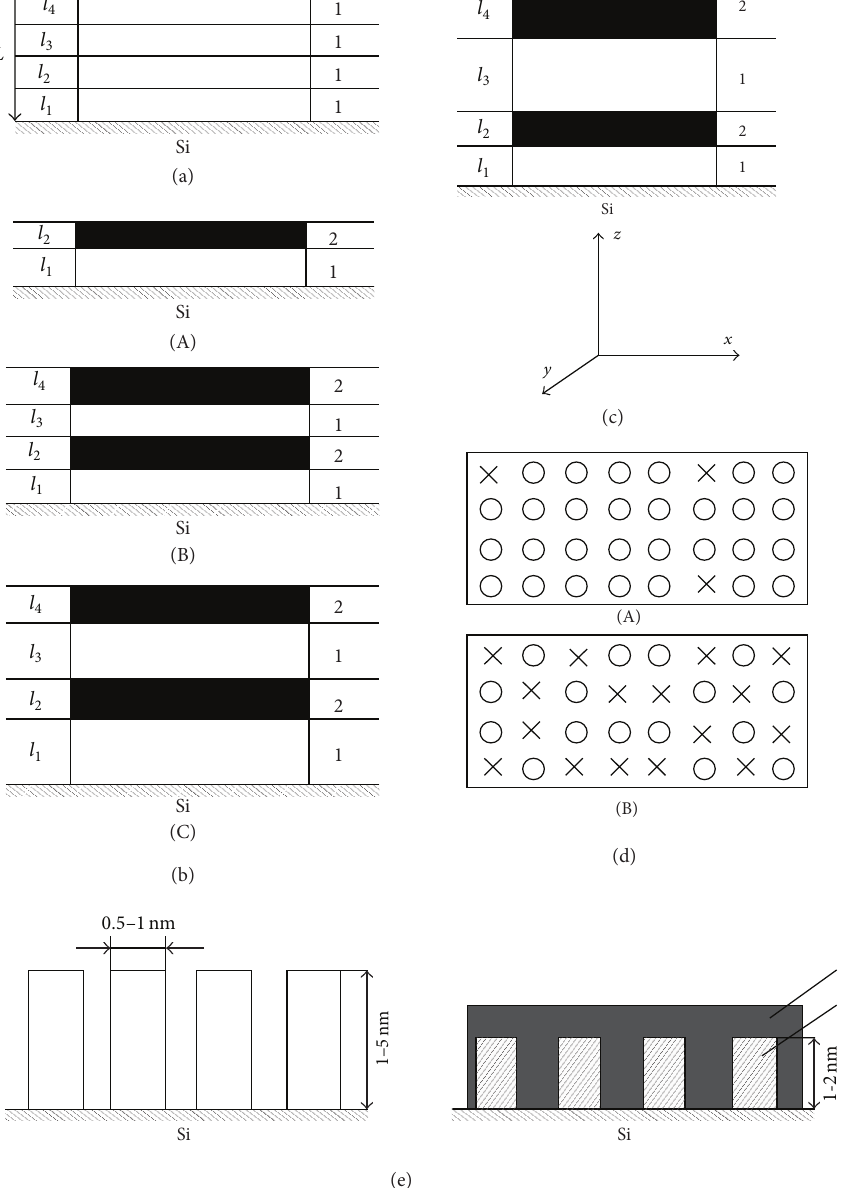
Figure 1: Scheme of two-dimensional nanostructures at silica surface. (a) Uniform distribution of chemical composition and structure, for example, monolayers of element-oxygen groups of a given composition: ( 𝑙 ) monolayer thickness; ( 𝐿 ) total layer thickness, 𝑙 1 = 𝑙 2 = 𝑙 3 = 𝑙 4 ; and (1) Ti-O monolayers. (b) Periodical distribution along the 𝑧 -axis of element-oxygen layers containing a certain number of monolayers: (1) Fe-O groups and (2) Ti-O groups ((A) two-layer structure, 𝑙 1 = 𝑙 2 and (B) four-layer structure, 𝑙 1 = 𝑙 3 and 𝑙 2 = 𝑙 4 ). (c) Aperiodic distribution of element-oxygen layers along the E -axis (four-layer structure with 𝑙 1 ̸= 𝑙 2 ̸=𝑙 3 ̸= 𝑙 4 ). (d) Aperiodic atomic distribution in the surface monolayer plane (top view): (crosses) Fe-O groups and (circles) Ti-O groups ((A, B) different Fe-O/Ti-O ratios). (e) Aperiodic distribution of “zero- dimensional” structures in the substrate plane: (1) Fe and (2)